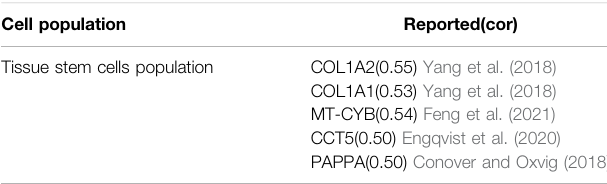
TABLE 2 | Stemness-related high-risk genes obtained from the tumor cell